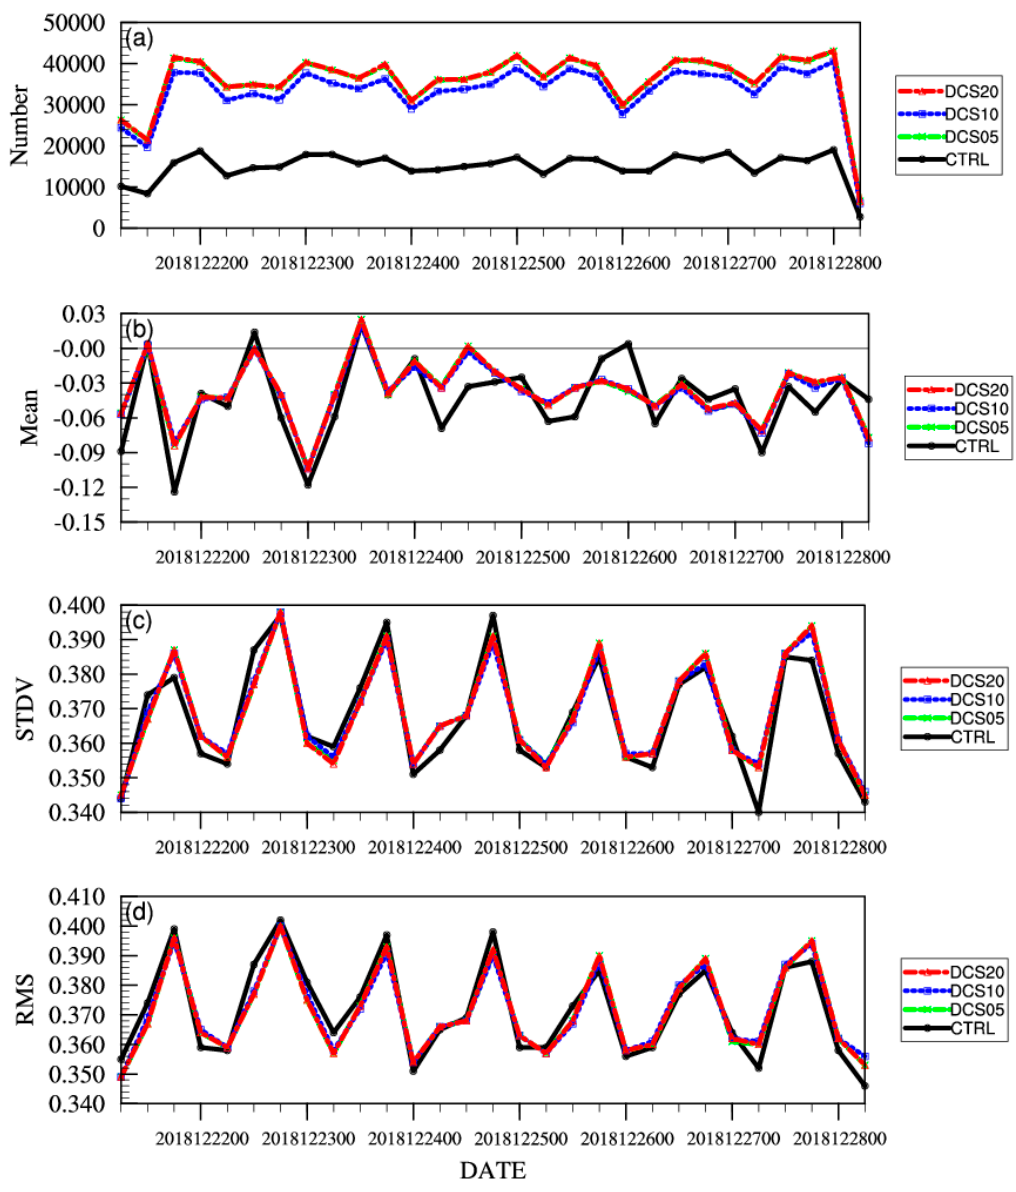
Figure 12. Same as Figure 11 but for MWTS-2 channel 6.